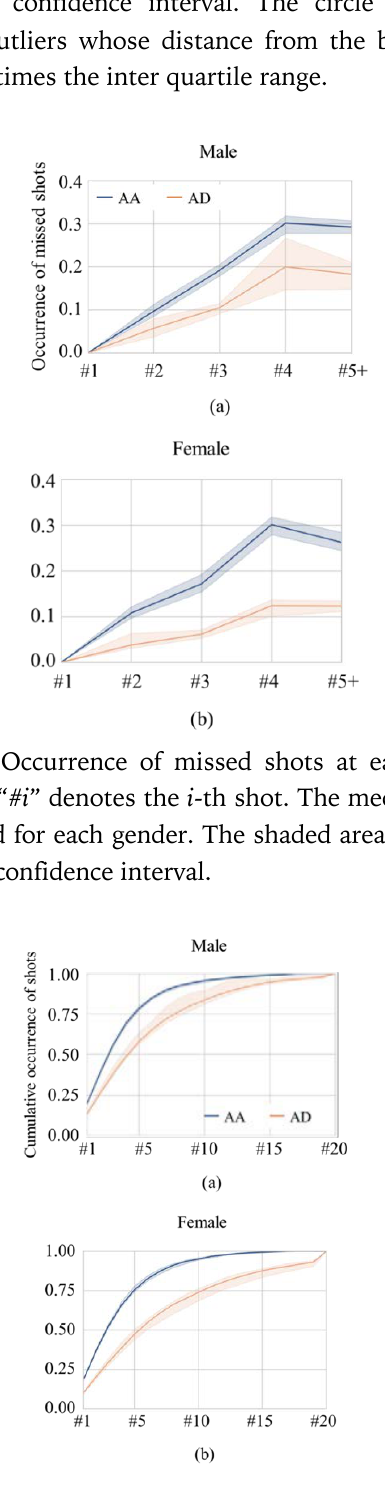
Figure 3 . Cumulative occurrence of shots per shot number. “# i ” denotes the i -th shot. The median was calculated for each gender. The shaded area denotes the 95% confidence interval.